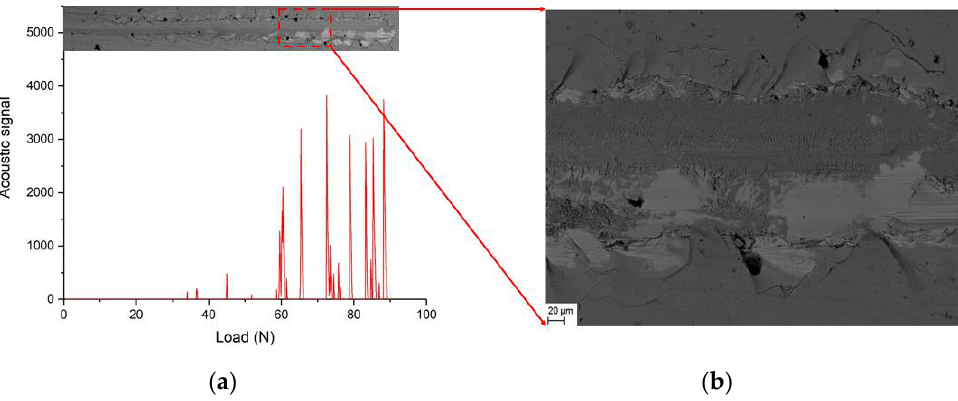
Figure 3. Scratch morphology and back scattered-electron image and scratch experiment acoustic signal image of TiN coating. ( a ) scratch experiment acoustic signal image; ( b ) back scattered-electron image.